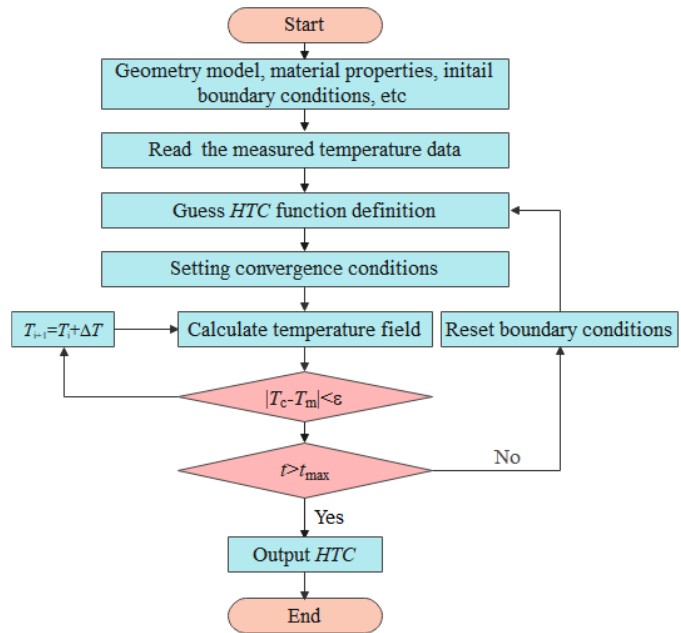
Figure 2. Flow chart of inverse heat conduction algorithm.